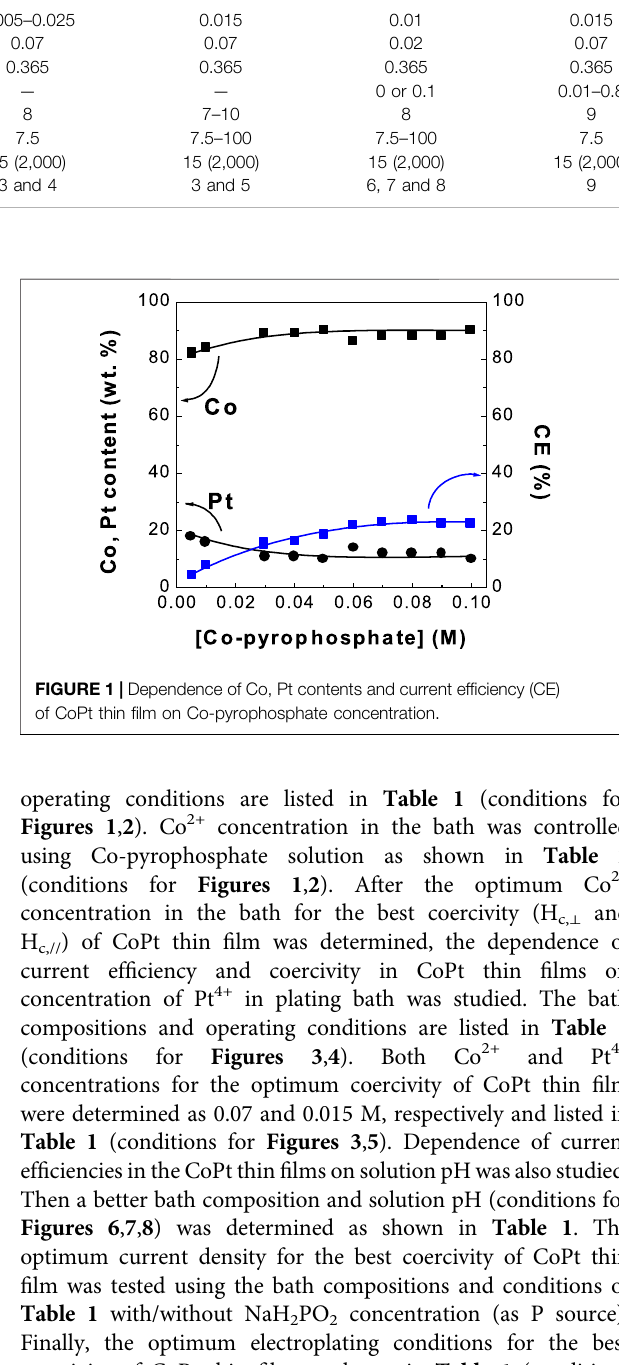
TABLE 1 | Bath compositions and operating conditions (unless otherwise noted) for binary CoPt thin fi lms (M (cid:1) mol dm − 3 ). Chemical/condition